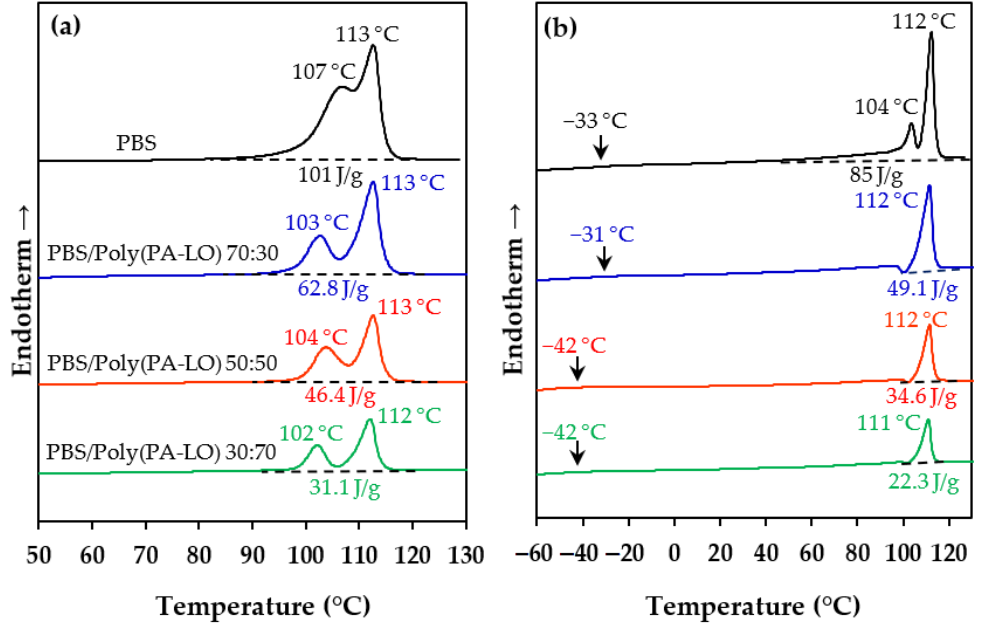
Figure 11. DSC first ( a ) and second ( b ) heating runs of PBS/poly(PA-LO) blends with the indicated weight ratios.